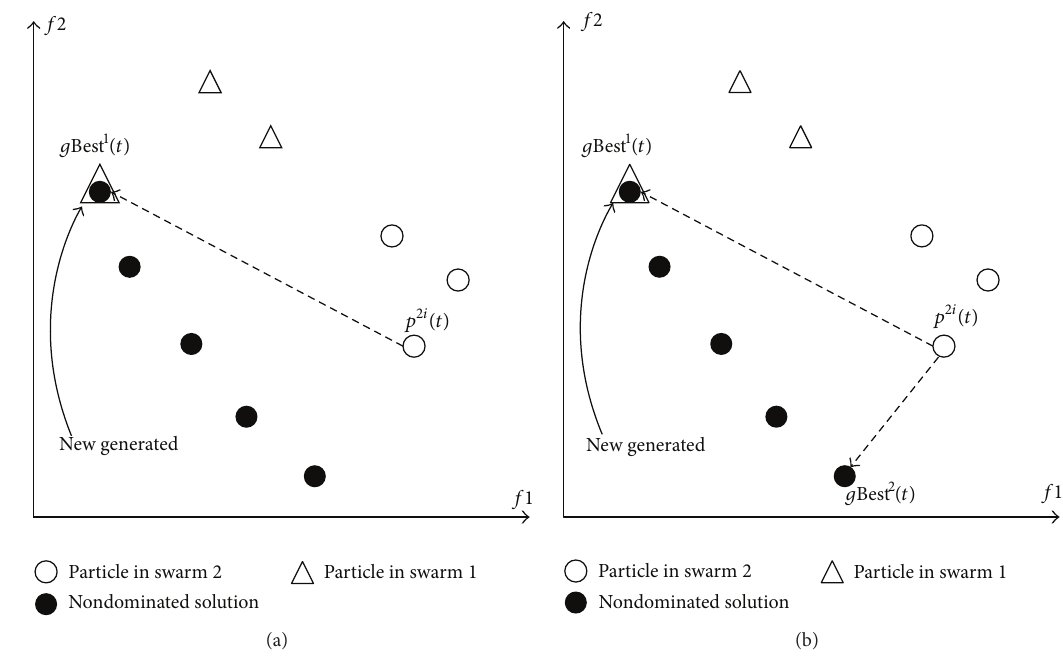
Figure 4: (a) A particle is guided based on 𝑔 Best 1 (𝑡) . (b) A particle is guided based on 𝑔 Best 1 (𝑡) and 𝑔 Best 2 (𝑡) . the diversity performance of the algorithm is expected to be better as the search area is wider, rather than a single